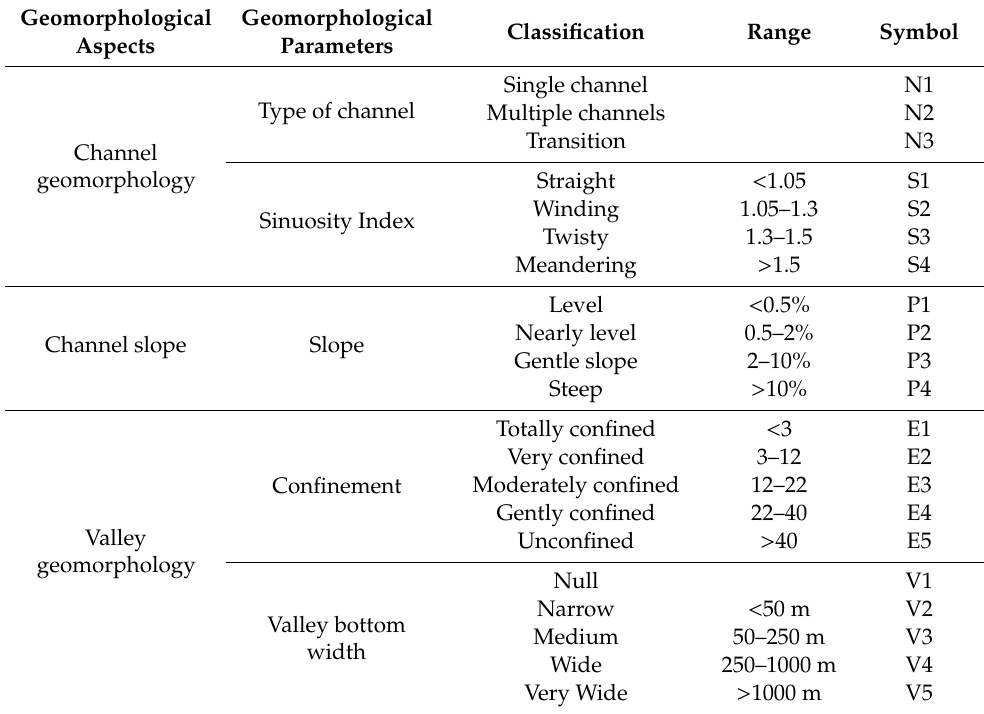
Table 2. Parameters and geomorphological aspects for river zoning and typification 1 .